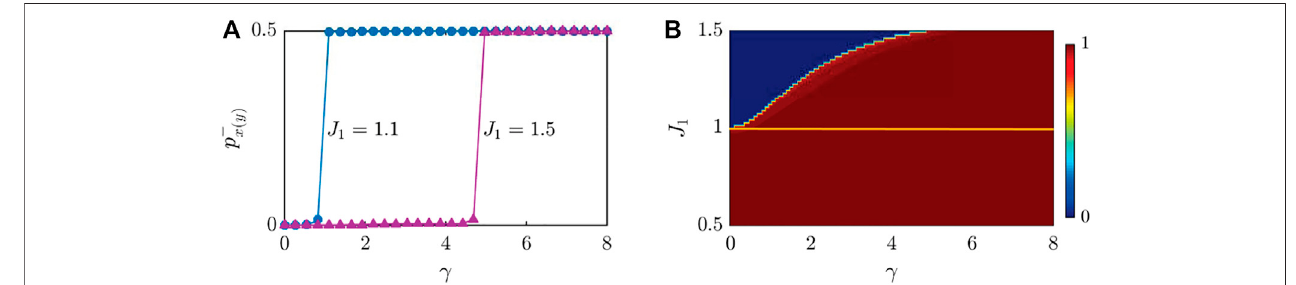
FIGURE 5| (A) Polarizations p − x (lines) and p − y (symbols) versus the gain-loss parameter γ with different coupling parameters J 1 . The color blue (magenta) indicates the coupling parameter is fi xed at J 1 = 1.1 ( J 1 =1.5). (B) Topological phase diagram ofeight-step non-unitary coinless DTQWs characterized bythe topological invariant